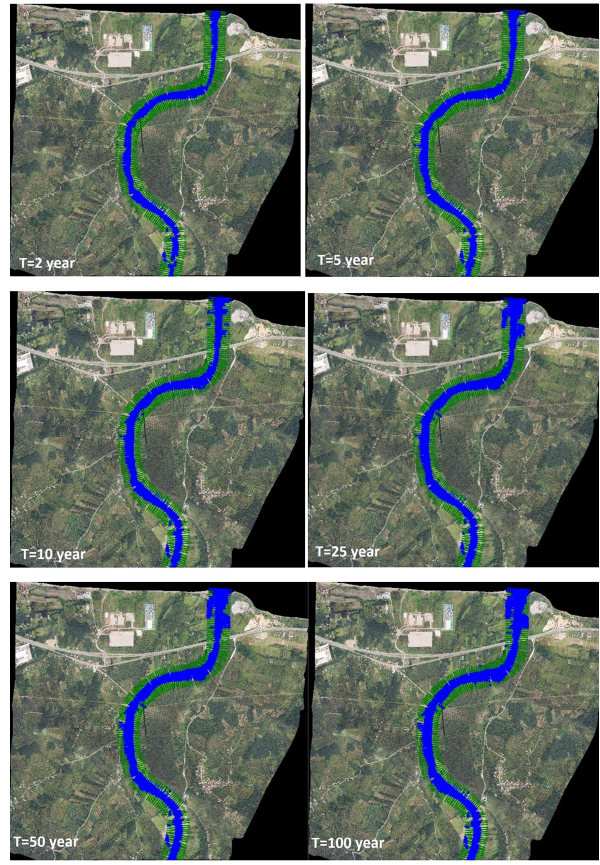
Figure 5. Results of local scale hydraulic model for different return period